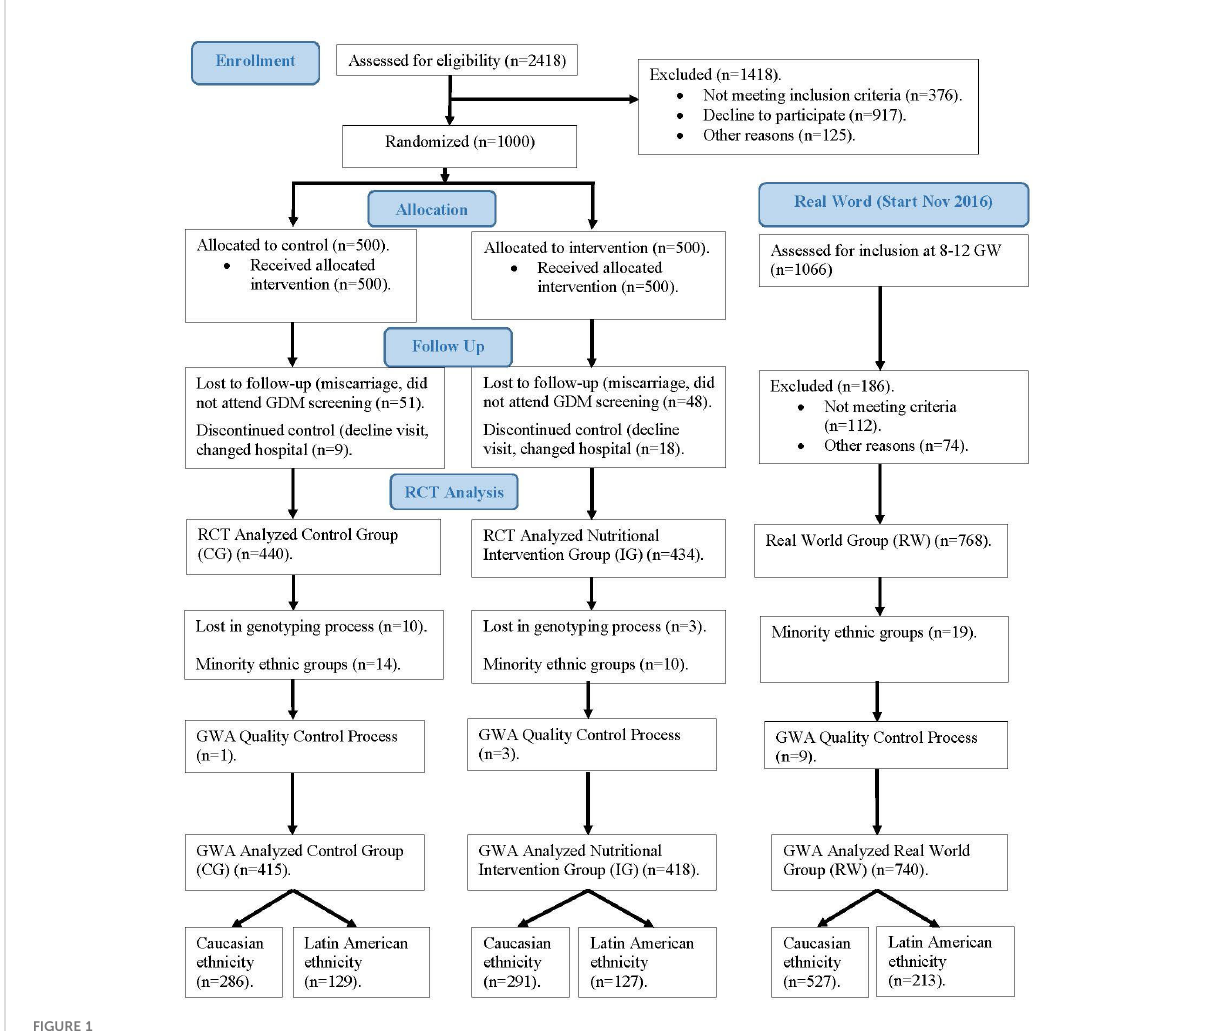
FIGURE 1 Flow diagram of women included in our